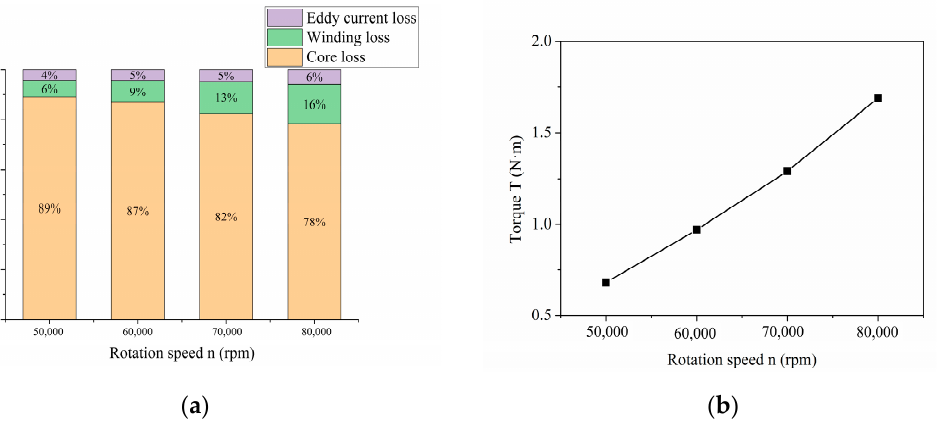
Figure 13. Motor simulation results under different revolutions. ( a ) Relationship between electro- magnetic loss and Revolution. ( b ) Relationship between torque and Revolution.